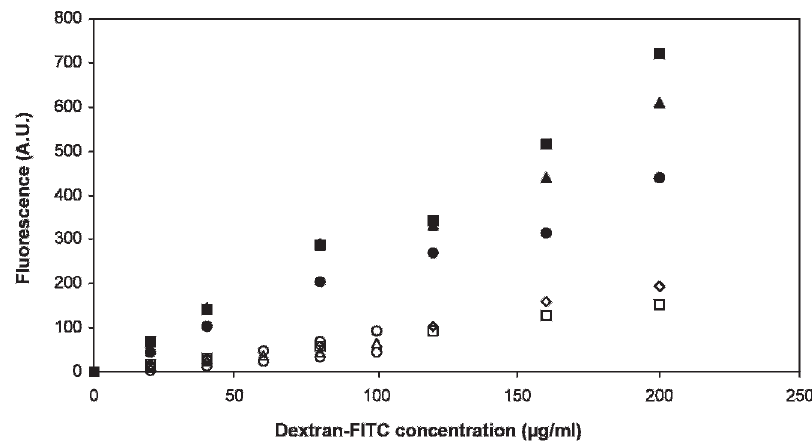
Figure 2 - Standard curves when using either water (open symbols) or PBS (closed symbols) as the